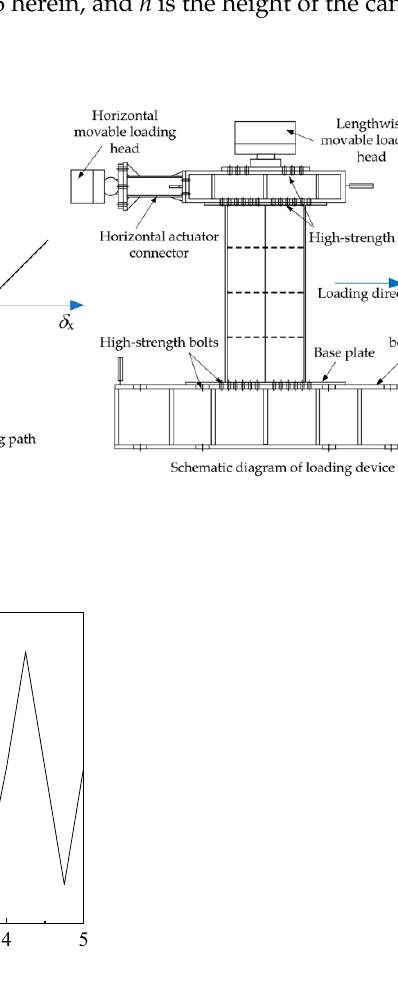
Figure 7. Loading path.